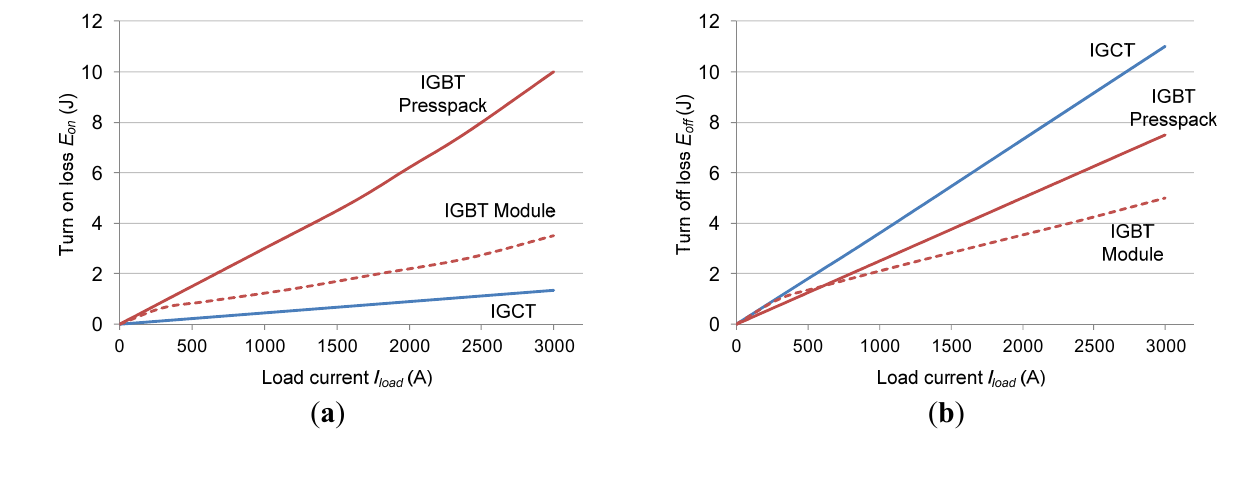
; ( b ) Turn off switching loss E on off